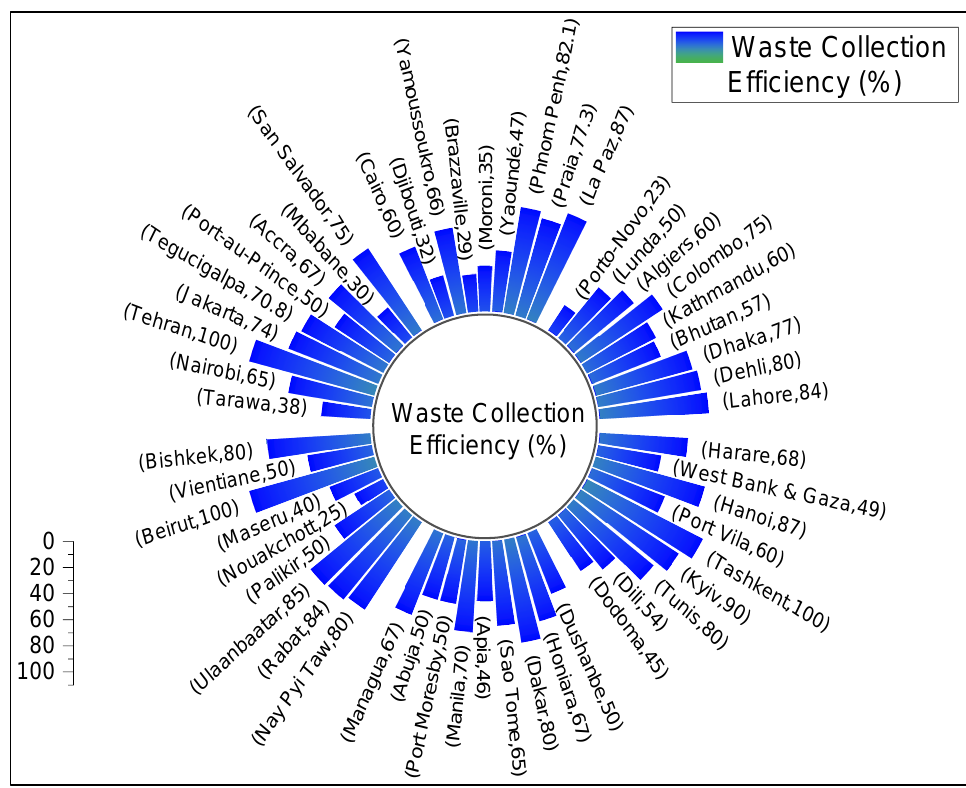
Figure 3. Waste collection efficiency (%) in Low – Middle-Income countries/cities. The low – middle-income cities/countries are further categorized into four groups based on waste collection efficiency [20,54 – 92]. Seventeen countries fall in Group-A with >75% waste collection efficiency, 18 in Group-B with >50% collection efficiency, 17 and 2 in Group-C and Group- D with >25% and ≤25% waste collection efficiency, respectively, as depicted in Table 1 and Figure 4. Table 1. Waste collection efficiency (%) in low – middle-income countries/cities. Groups